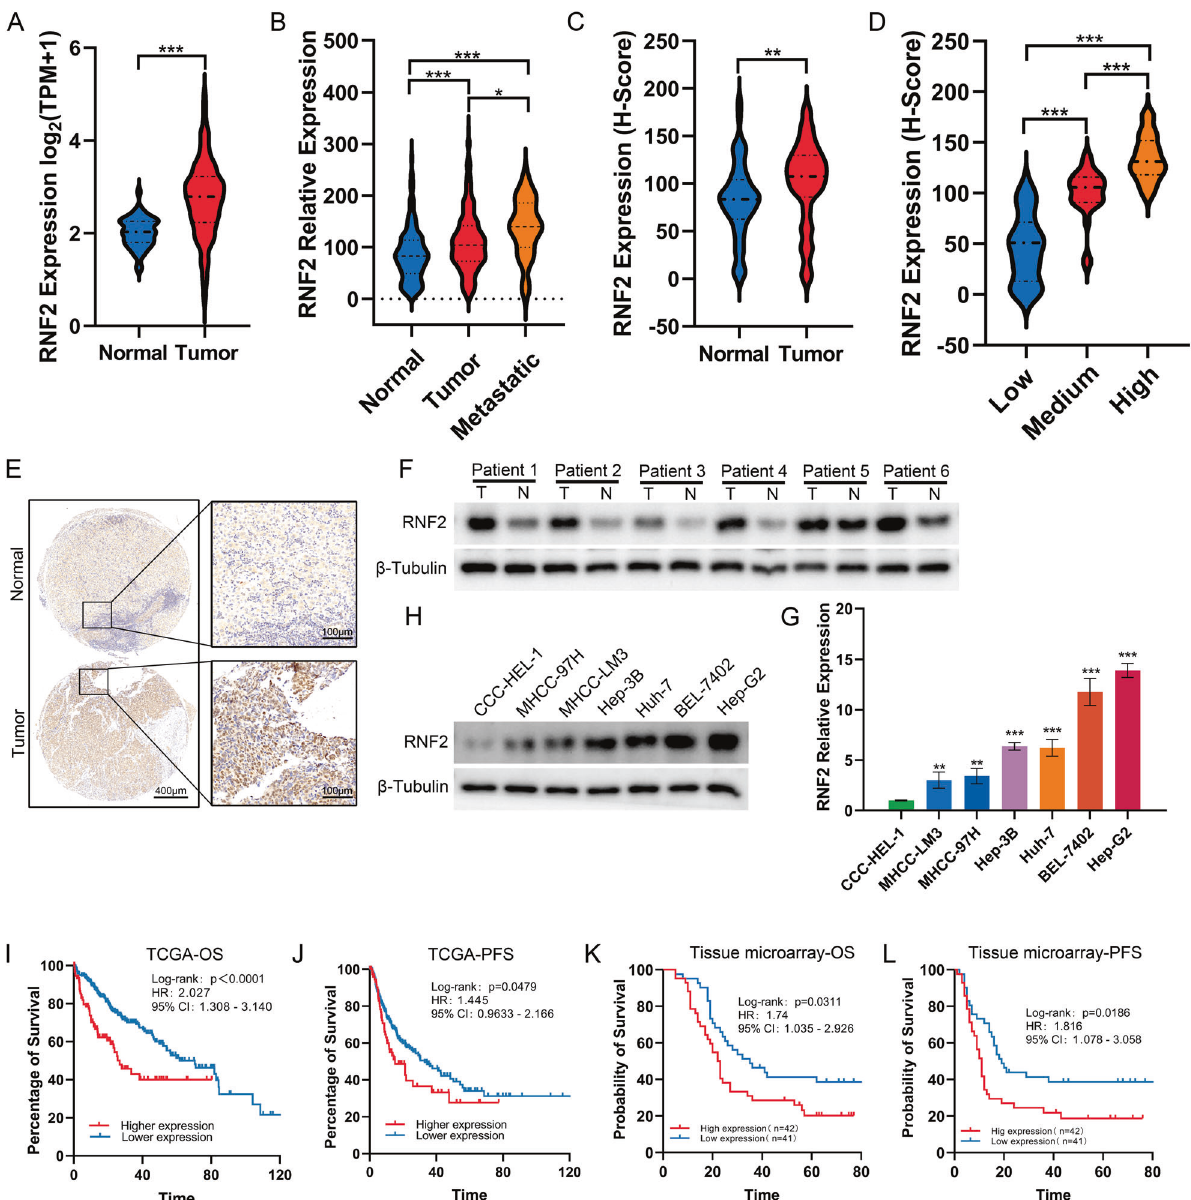
Fig. 1 Upregulated RNF2 indicates poor prognosis of HCC patients. A The expression level of RNF2 in tumor and normal tissues was analyzed using TGCA-LIHC dataset. B By fi ltering and analyzing the data in TGCA-LIHC dataset, the expression of RNF2 in normal, tumor and metastasis showed that RNF2 was signi fi cantly up-regulated in tumor and metastasis, and the expression in metastasis was higher than that in tumor. C Analysis of RNF2 protein expression in 83 pairs of cancer and normal tissues by immunohistochemistry staining with tissue microarray showed that RNF2 was highly expressed in tumor. D According to the IHC H-Score of 83 HCC specimens, they were divided into low, medium and high groups. Analysis of the expression of RNF2 protein suggested that the expression of RNF2 gradually increased with the grouping. E Representative IHC staining images show RNF2 in normal and cancer tissues. F WB results showed the protein expression of RNF2 in 6 pairs of HCC patients ’ surgical specimens (T: tumor, N: normal tissue). G Quantitative RT-PCR results revealed the expression levels of RNF2 in six HCC cell lines and normal liver cell line. H WB results showed the expression level of RNF2 in 6 HCC cell lines and normal liver cell line. I – J Kaplan-Meier analysis showed that HCC patients with high RNF2 expression in TGCA-LIHC dataset were signi fi cantly associated with lower OS and PFS. K – L Kaplan-Meier analysis showed that HCC patients with high RNF2 expression in our own cohort were signi fi cantly associated with lower OS and the deposition of H3K4me3, so we also added to measure their and the overexpression of RNF2 had opposite effects. Similar expression levels. [10, 11, 15, 27] results were detected that knockdown of NR2C2 promoted the Further, we investigated how RNF2 modulate H3K27 and H3K4 level of H2AK119ub and H3K27me3 but decreased that of trimethylations. Previous studies indicated that EZH2 and MLL1 H3K4me3 (Supplementary Fig. S6). Previous studies revealed a crosstalk mechanism between H2A ubiquitination and H3K methylation, for instance, the increase of H2AK119ub positively affects the deposition of H3K27me3 but has the opposite effect on